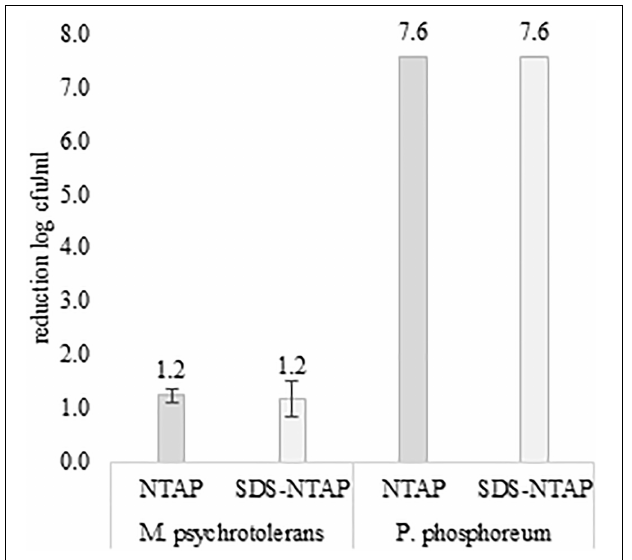
FIGURE 2 | Histamine concentration in TSBH+ at 20 ◦ C for 24 h (A) and 5 ◦ C for 48 h (B)